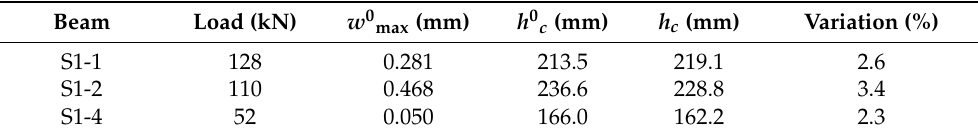
Table 10. Comparation between theoretical and actual values of crack